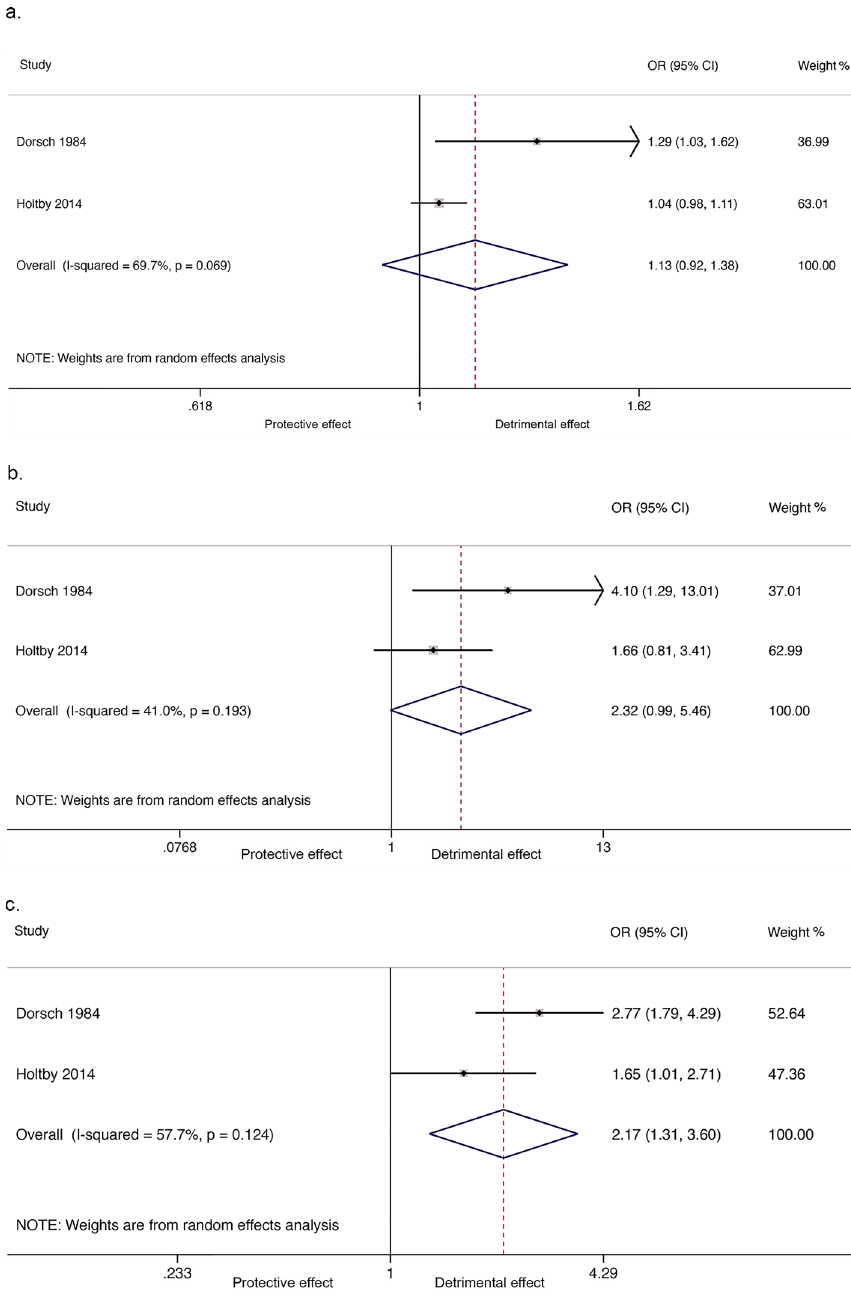
Figure 3. Forest plot for the association between nitrate in drinking water and any birth defects. ( a ) Linear relationship; ( b ) Highest versus the lowest exposure; ( c ) All combined higher versus the lowest